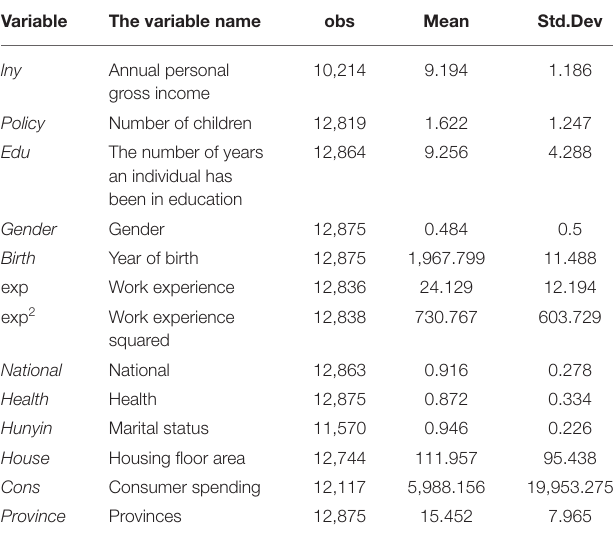
TABLE 3 | Sample size and distribution: 2007–2009.